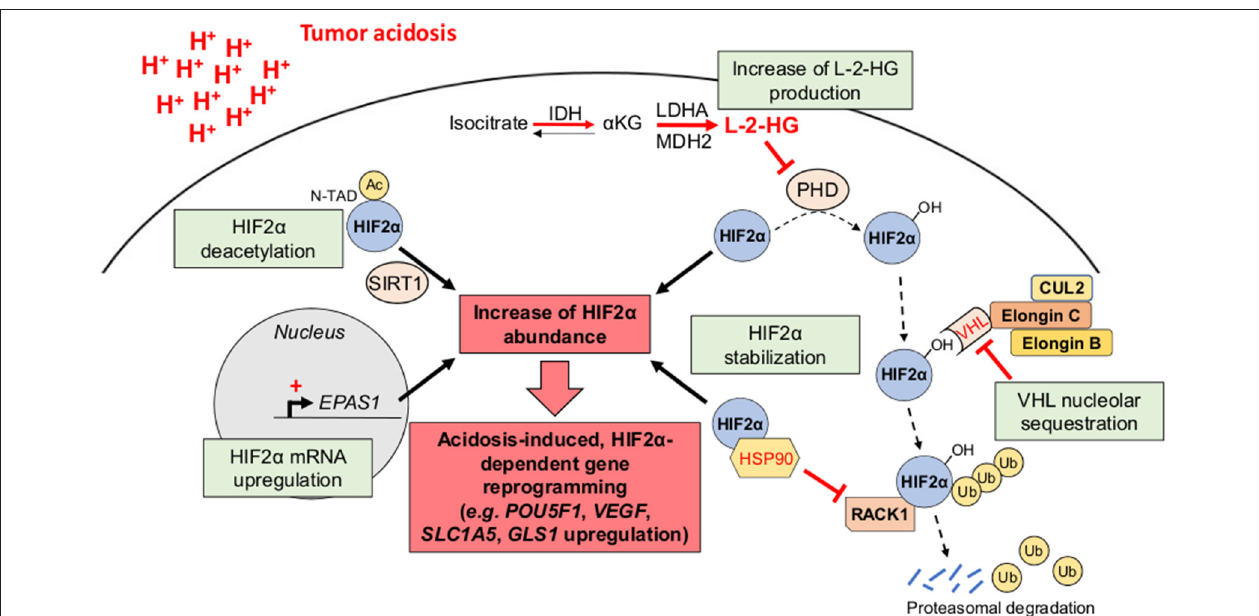
FIGURE 3 | HIF2 α as a transcriptional regulator of acidosis-induced gene reprogramming. Tumor acidosis leads to an increase of HIF2 α abundance either by directly inducing EPAS1 gene transcription or by promoting HIF2 α protein stabilization. For the latter, several mechanisms have been proposed, including the nucleolar sequestration of the von Hippel-Lindau (VHL) protein, the competitive binding of the chaperone heat shock protein 90 (HSP90) instead of the receptor of activated protein kinase C (RACK1), and an increased L-2-hydroxyglutarate (L-2-HG) production, thereby inhibiting HIF2 α hydroxylation and subsequent proteasomal degradation. Besides its stabilization, acidosis also enhances HIF2 α transcriptional activity through sirtuin-mediated deacetylation of lysine residues in its regulatory amino-terminal transactivation domain (N-TAD). α KG, α -ketoglutarate; Ac, acetyl group; CUL2, cullin-2; IDH, isocitrate dehydrogenase; LDHA, lactate dehydrogenase A; MDH2, malate dehydrogenase 2; PHD, prolyl hydroxylase; Ub,